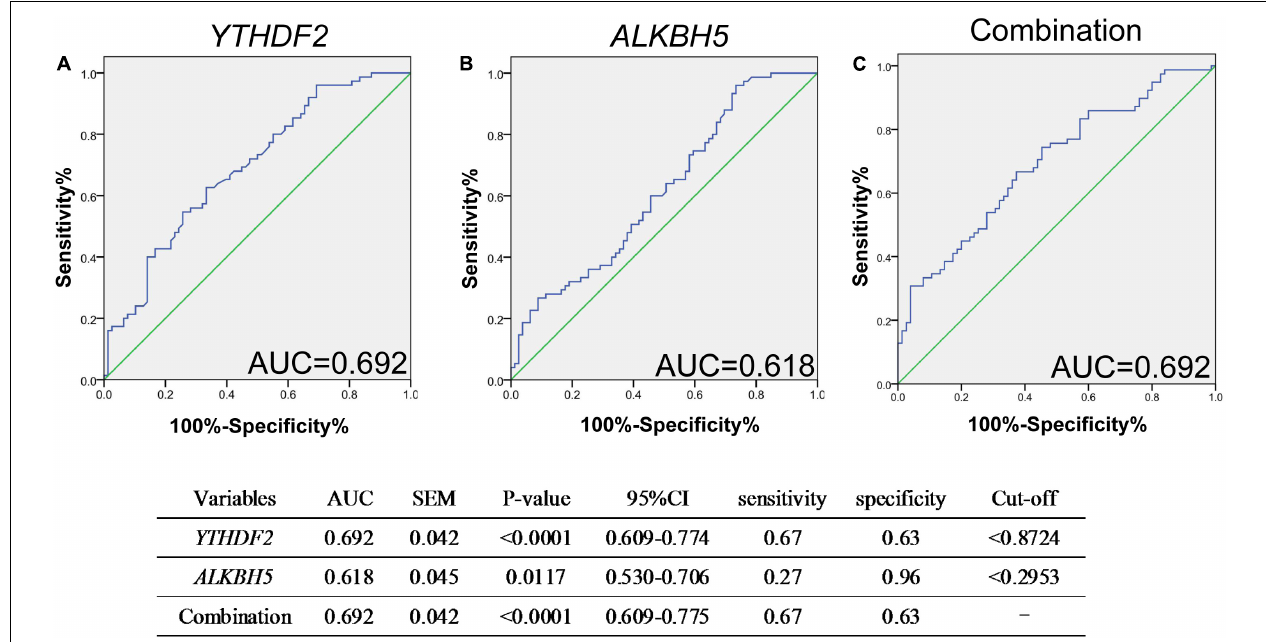
FIGURE 3 | ROC analysis showed that mRNA YTHDF2 has a better predictive value for AS. (A) ROC analysis of mRNA YTHDF2. (B) ROC analysis of mRNA ALKBH5. (C) ROC analysis of combination of mRNA YTHDF2 and ALKBH5. ALKBH5, alkylation repair homolog protein 5; AS, ankylosing spondylitis; ROC, receiver operating characteristic; YTHDF2, YT521-B homology domains 2. Blue and green lines indicates ROC and line of identity, respectively.